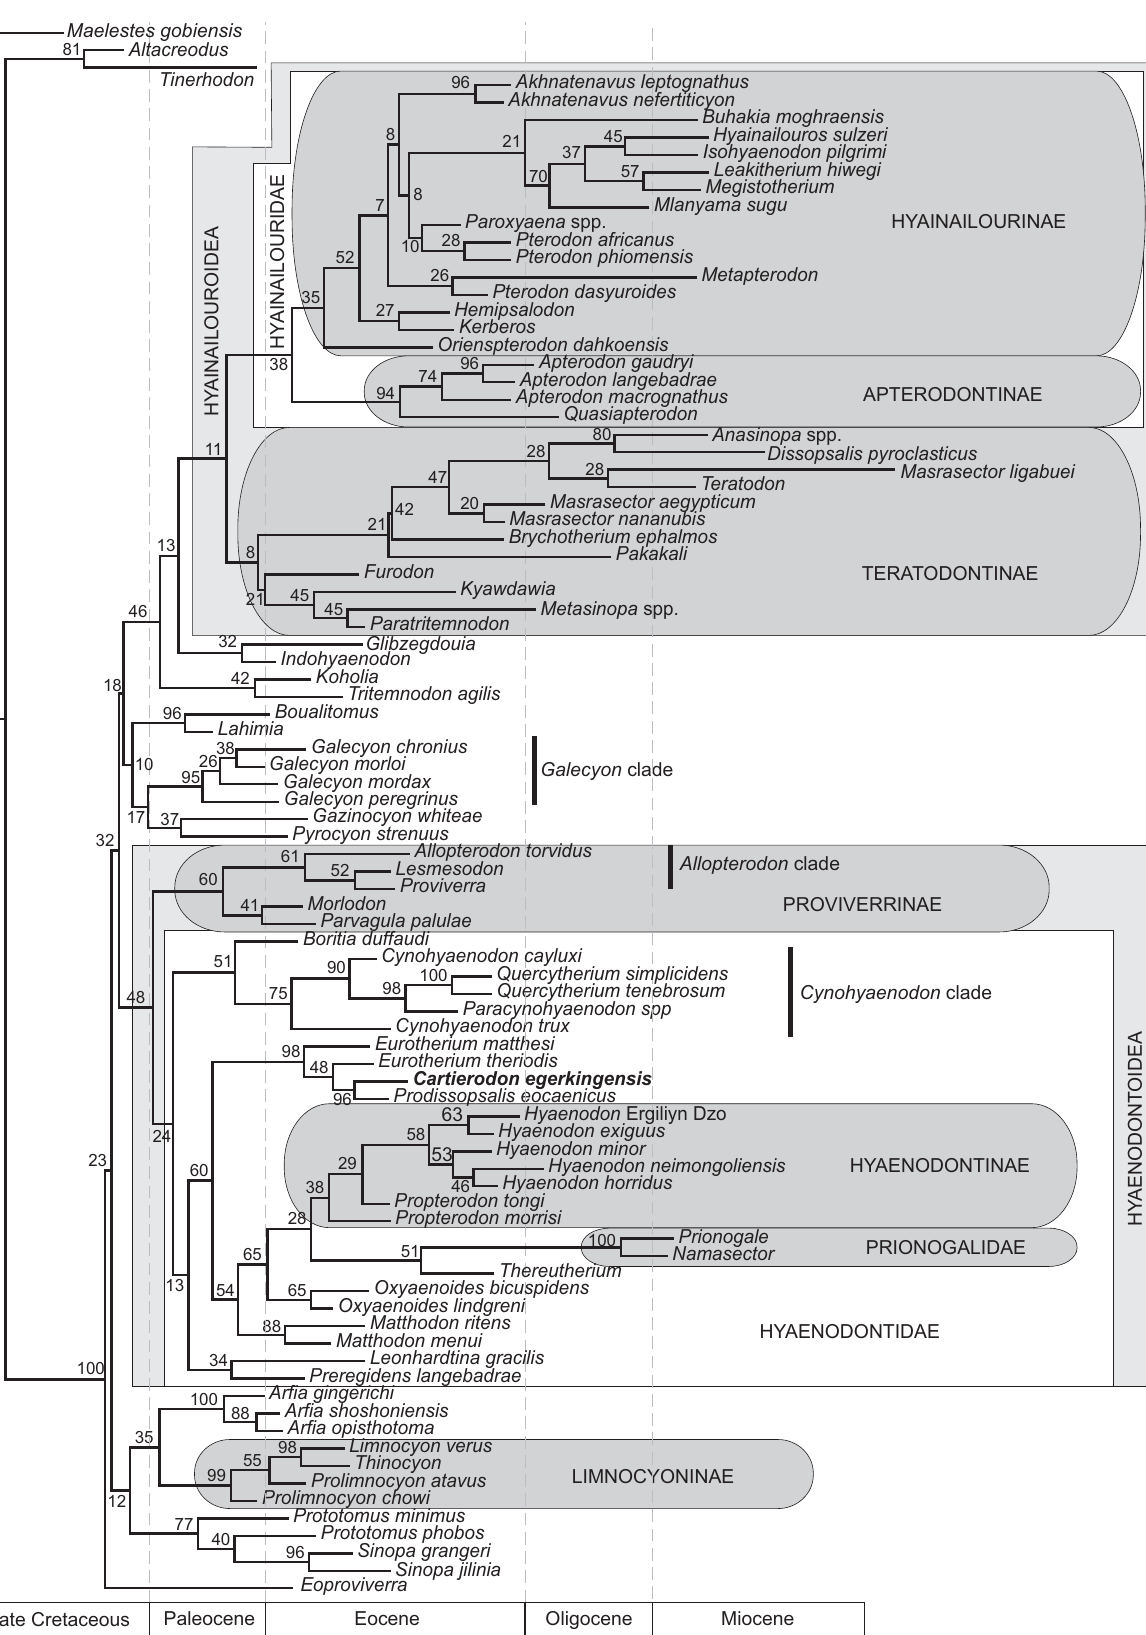
Fig. 5. Results of the phylogenetic analysis of Hyaenodonta character- taxon matrix. Results are visualized as an “all compat” (majority rule plus compat- ible groups) consensus tree. Major named clades recovered or discussed in this analysis and recovered in other analyses are